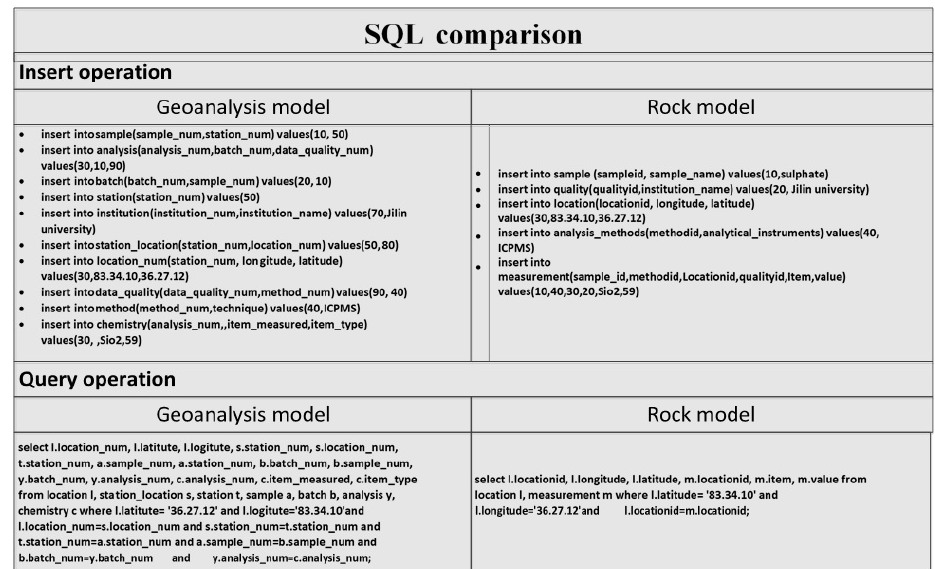
Figure 6. Comparison of insert and query operations in structured query languages